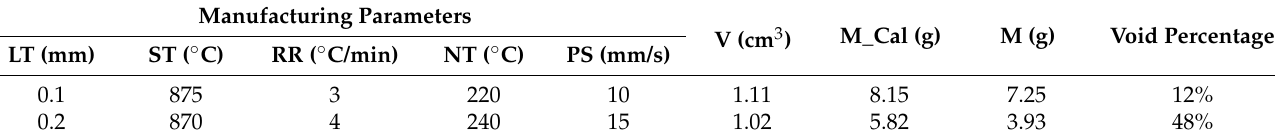
Table 2 shows two examples of void percentages. Table 2. Void percentage